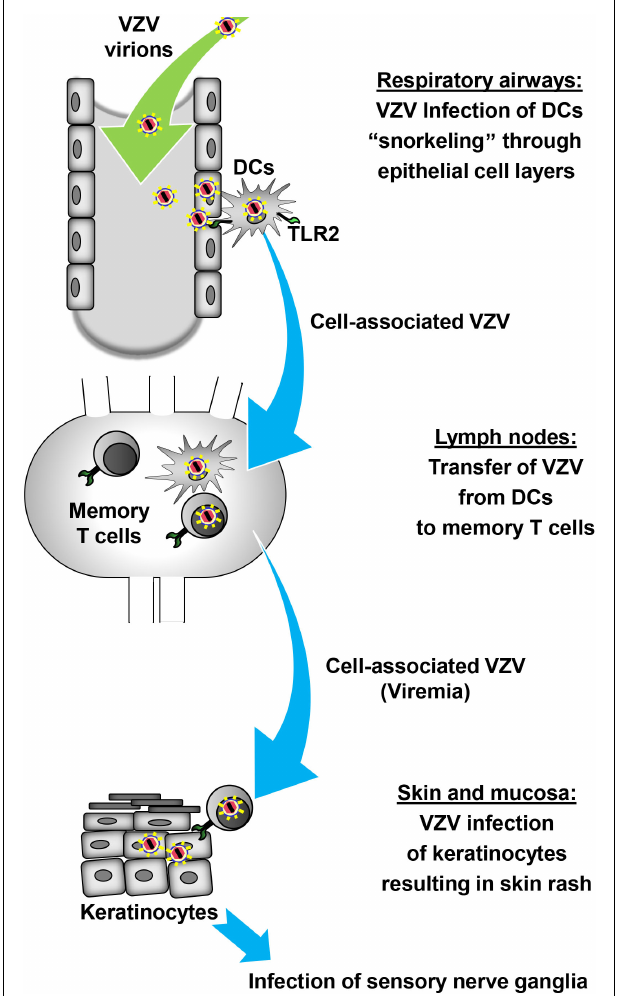
FIGURE 1 | Model of DC-assisted viral dissemination during primary VZV infection. After inhalation of VZV-containing aerosols intraepithelial DCs that extend projections into the lumen of the airways, analogous to “snorkeling,” pick up VZV directly or from infected epithelial cells. Upon recognition of VZV through PRRs such as TLR2 intraepithelial DCs and possibly other cells infected with VZV start to migrate to the lung-draining lymph nodes in the first phase of cell-associated viral dissemination. At this site, DCs transfer VZV to memory T cells which subsequently carry VZV in the second phase of cell-associated viral dissemination to the skin. VZV-infected memory T cells infect keratinocytes either directly or indirectly through infection of other skin-resident cells which subsequently transfer the virus to keratinocytes. Finally, VZV replicating in the skin causes the typical rash followed by latent infection of sensory